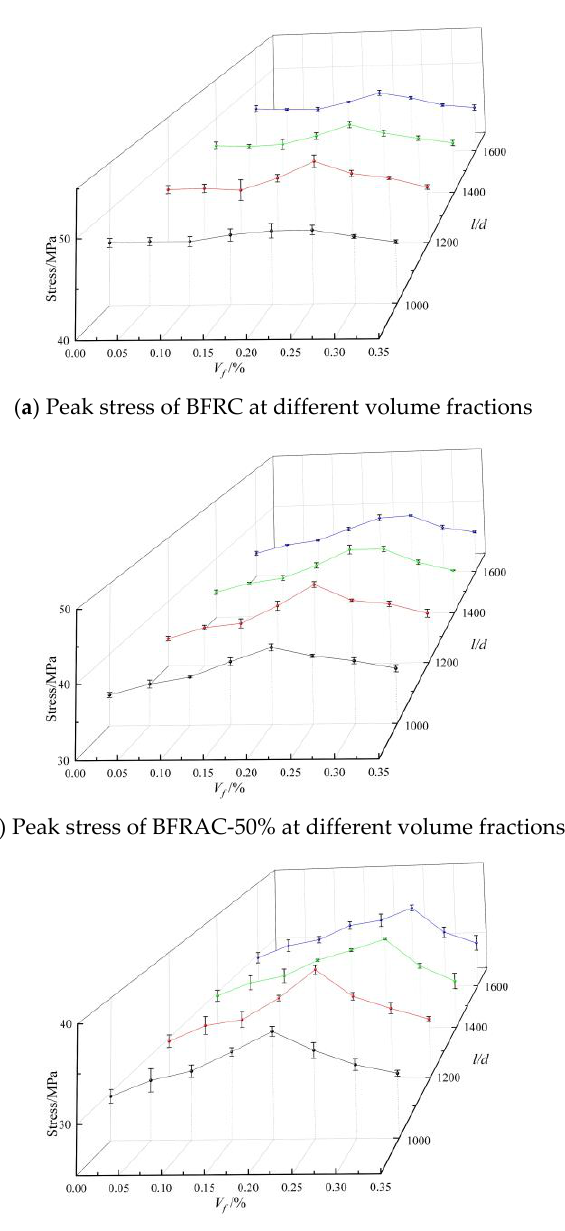
Figure 10. Peak stress of BFRAC under uniaxial compression.